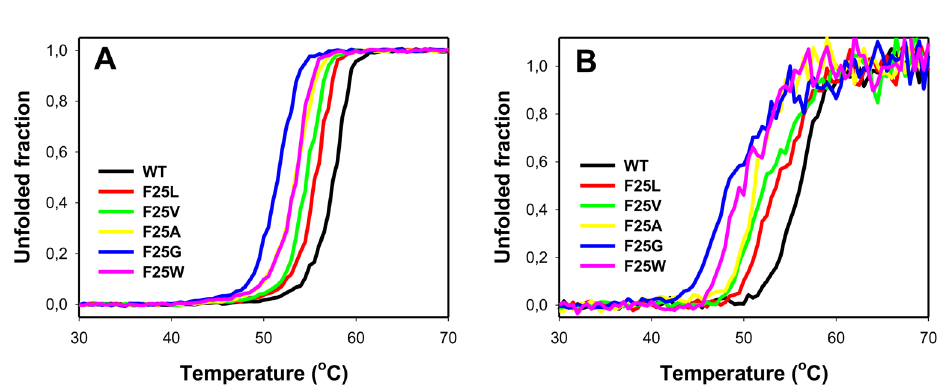
Figure 3. Thermal denaturation of hPGK1 variants monitored by CD spectroscopy. Signals corresponding to the Far-UV (222 nm) and the Near-UV (290 nm) are shown in panels ( A ) and ( B ), respectively. In both cases, linear pre- and post-transition baselines were applied to normalize data. Protein concentration was about 7 µM (Far-UV) and 15 µM (Near-UV). Experiments were performed in K-phosphate 20 mM, pH